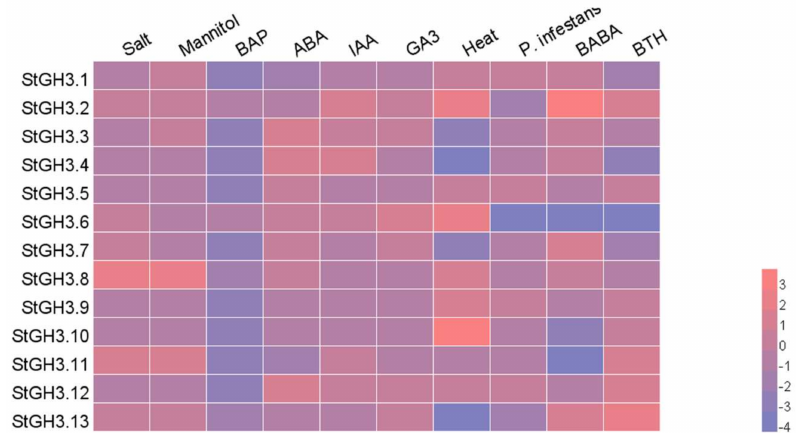
Figure 5. The heatmap based on the RNA-seq database under 10 treatments, which include biotics, abiotics, and hormones. The RNA-seq database was processed by log2 and stress, and hormonal data were compared with the control data. In the heat map, upregulated expression is in red and downregulated expression is in blue